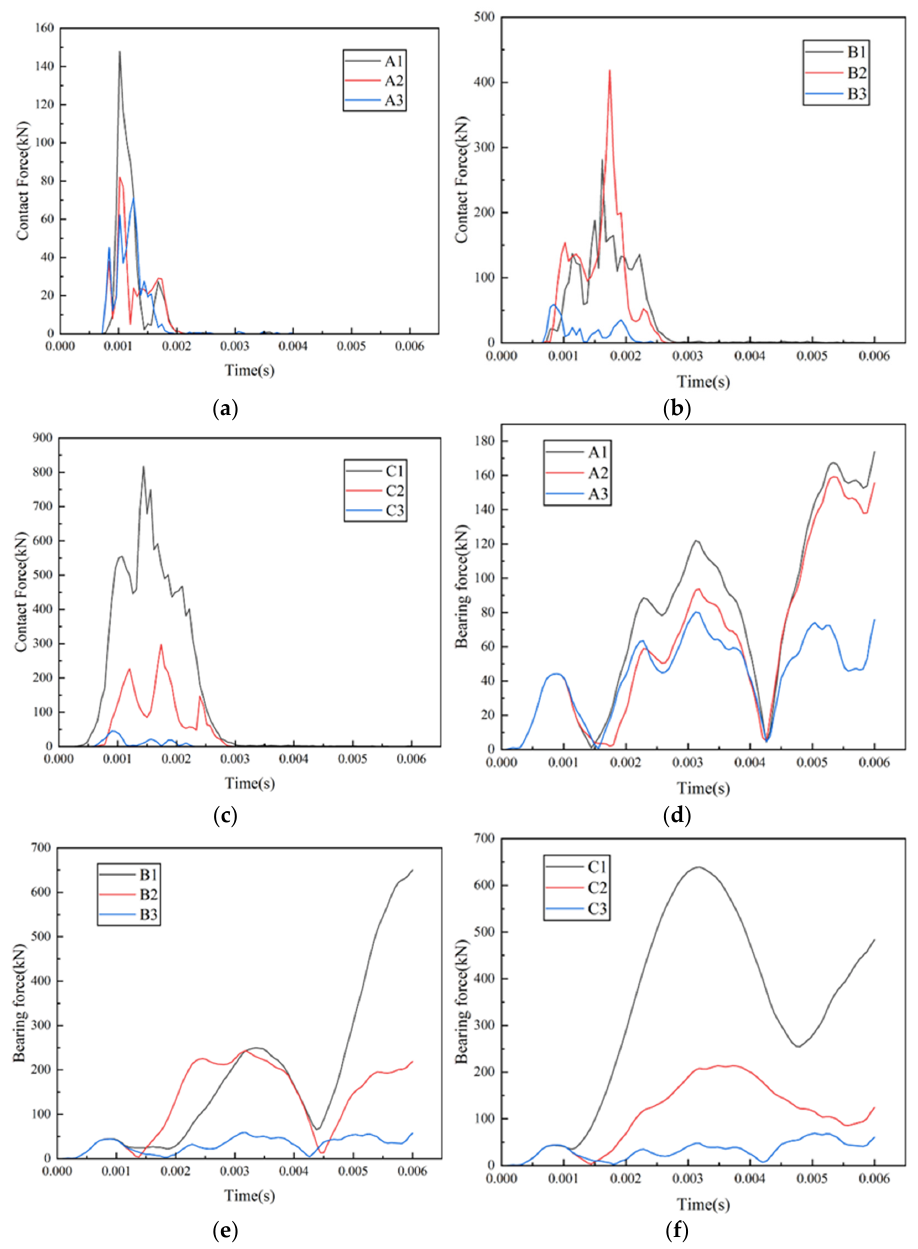
Figure 8. Contact force vs. time: ( a ) small flocking birds; ( b ) medium flocking birds; ( c ) large single bird. The bearing force vs. time: ( d ) small flocking birds; ( e ) medium flocking birds; ( f ) large single bird.